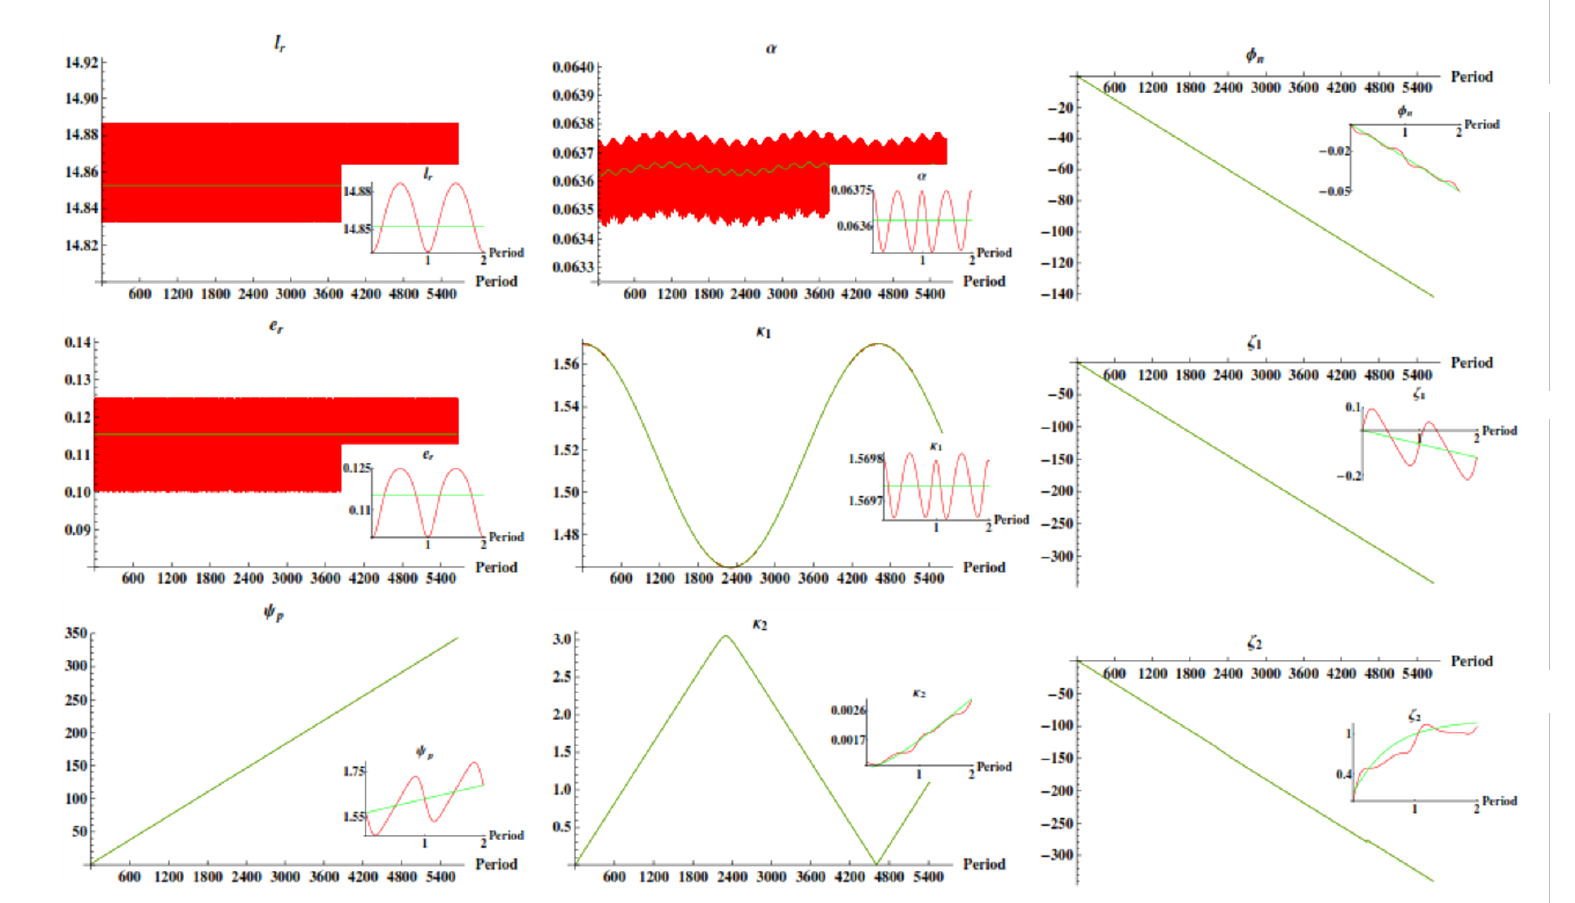
Figure 1. From the upper left diagram to the lower right, the evolutions of l r , e r , α , φ n , ψ p , κ i , ζ i ( i = 1,2) are depicted, respectively, as function of the number of orbital periods. They are driven by the secular (green curves) and the instantaneous dynamics (red curves). The parameters and initial conditions are chosen as: total mass m = 10 M (cid:12) , mass ratio ν = 1.0, dimensionless spin parameters χ 1 = 0.95, χ 2 = 0.05, eccentricity e r = 0.1, spin polar angles κ 1 = π /2, κ 2 = 0.001, spin azimuthal angles ζ 1 = 0, ζ 2 = 0, longitude of the ascending node φ n = 0. The shape variables l r , e r gives the post-Newtonian parameter ε = ( 1 + e r ) l 2 r